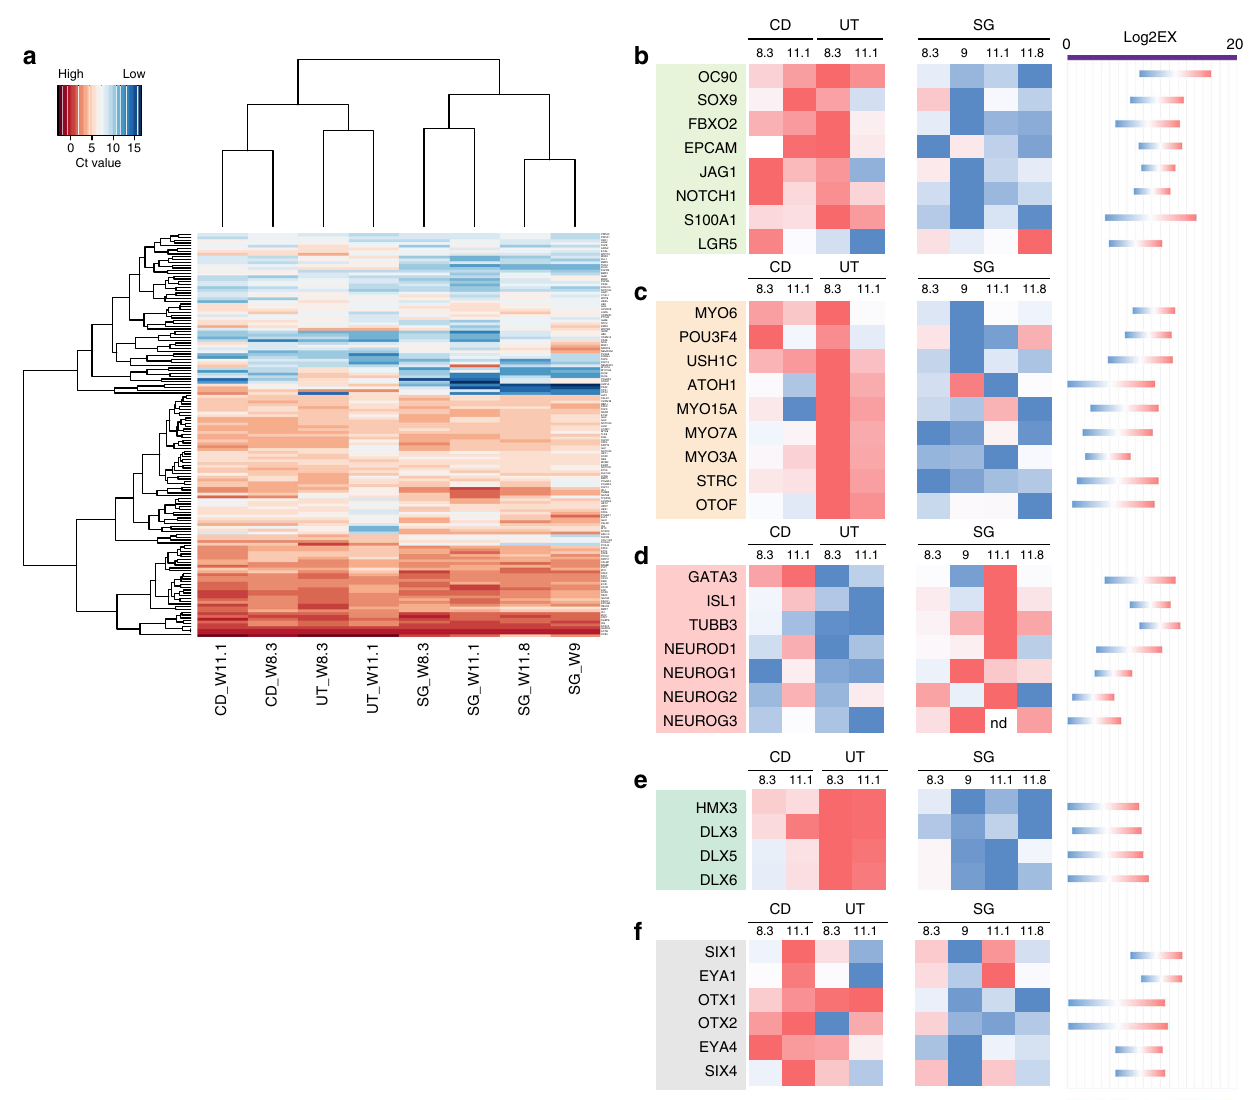
Fig. 3 Gene expression analysis of the microdissected cochlear duct, utricle, and spiral ganglion. a Ct values obtained with multiplex qRT – PCR were used for hierarchical clustering. Strongly expressed genes with mean normalized Ct values below 10 are shown. Levels of expression are indicated by the color code. b – f Relative expression level of each gene among the three different tissues across multiple samples. The color code shown is a red-to-blue gradient binned into eight discrete values, with dark red indicating the highest expression level among the samples and blue the lowest. The range of expression values for each gene represented by the color range is shown on the right for each gene as Log2EX value (limit of detection) -the raw Ct value. b Epithelial and supporting cell markers; c hair cell markers; d neuronal genes; e vestibular organ development; f early otic development. Samples used for these experiments were E1204, E1208, E1235 and